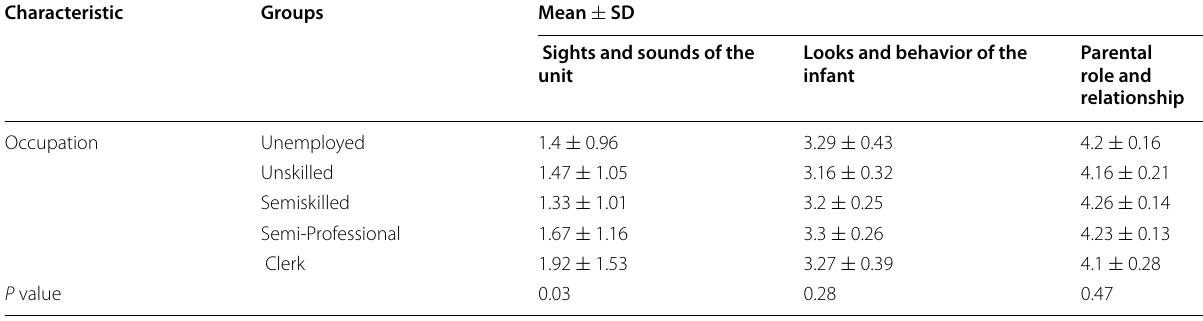
Table 3 Mean Stress Scores of each domain of PSS: NICU scale in relation to occupation of the mother